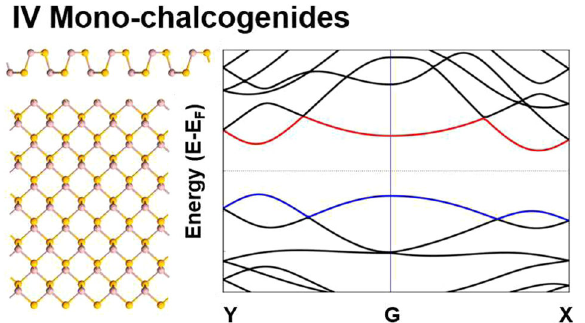
Fig. 19 Structure and Electronic Properties of MCs. The side-view and top view representations (5 × 5 × 1 Supercell) of the monolayer group IV mono-chalcogenides and its energy-crystal wave vector (E- k) dispersion relations where the conduction band and valance band are marked in red and blue, respectively.